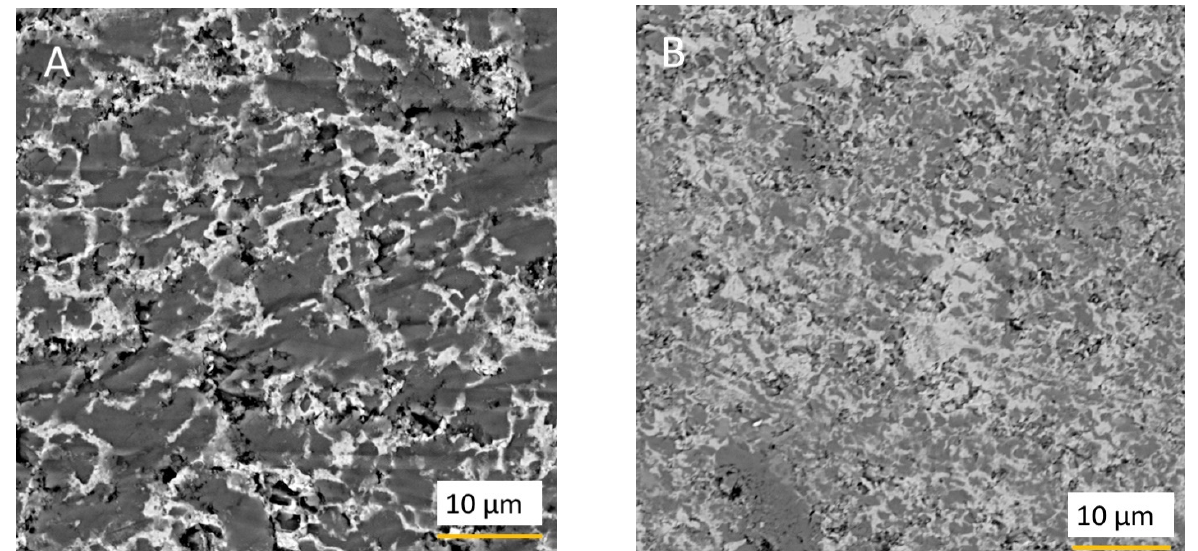
Figure 7. SEM-BSE micrographs of the sample I, HPF 1150 °C, 120 min ( A ) free surface; ( B ) polished section.